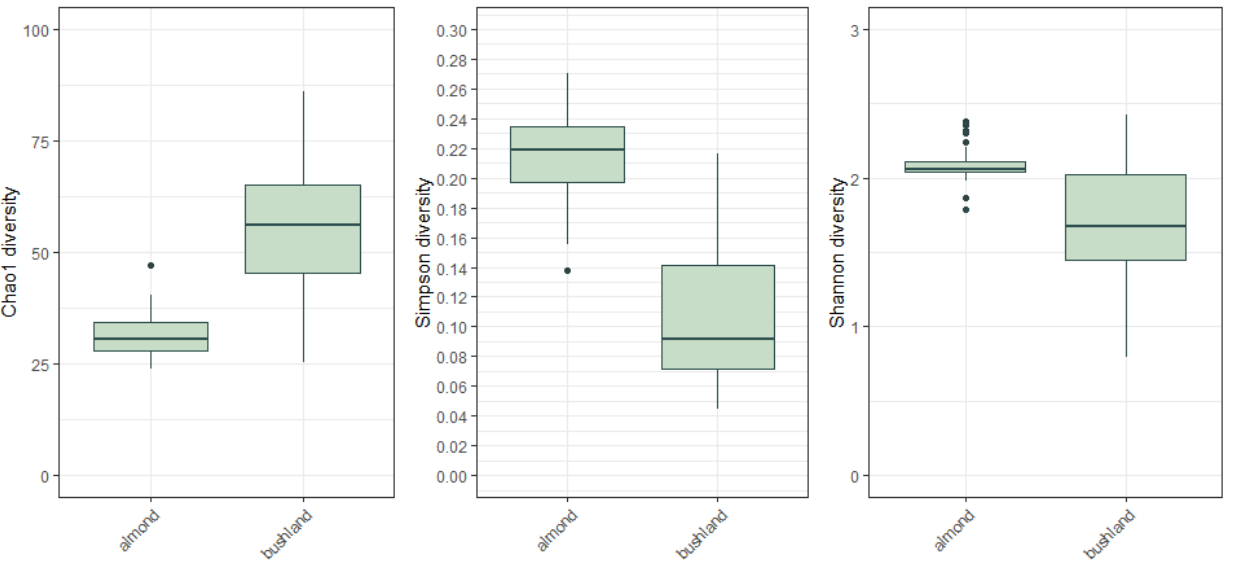
Figure 8. Alpha species diversity indices (Chao1, Simpson, Shannon) show differences for pollen taxa based on metabarcoding of pollen sampled for each site and over all days.